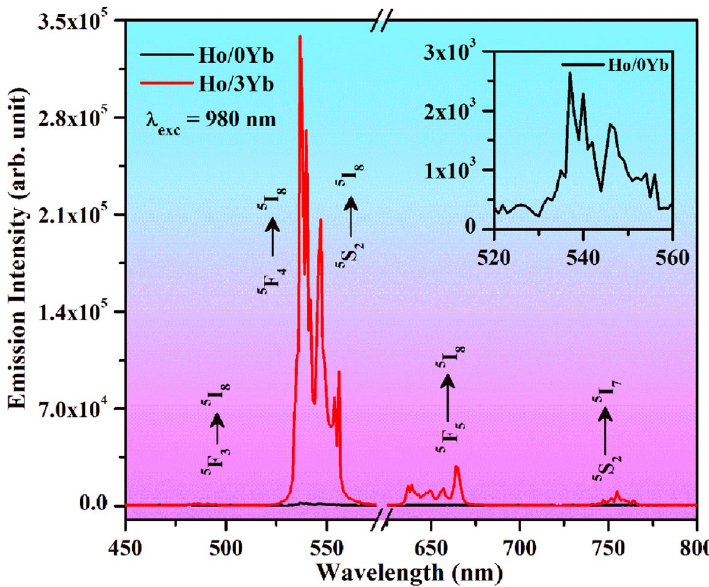
Figure 7. The upconversion emission spectra of Ho 3+ /0Yb 3+ and Ho 3+ /3Yb 3+ doped and co-doped ZnGa 2 O 4 materials under 980 nm excitations at 31.84 W/cm 2 . The inset figure shows the enlarged emission spectrum of Ho 3+ /0Yb 3+ doped phosphor for the green